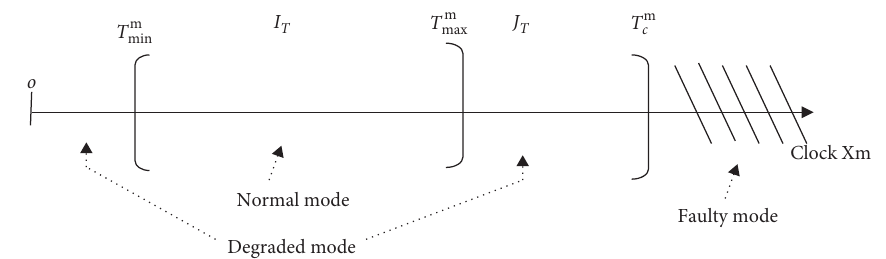
Figure 9: Travelling duration and functioning